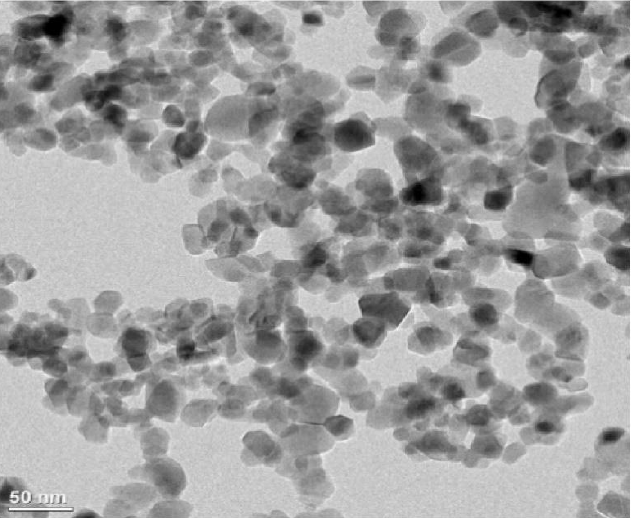
Figure 1. TEM image of the P25 purchased from EVONIK Co., Ltd.